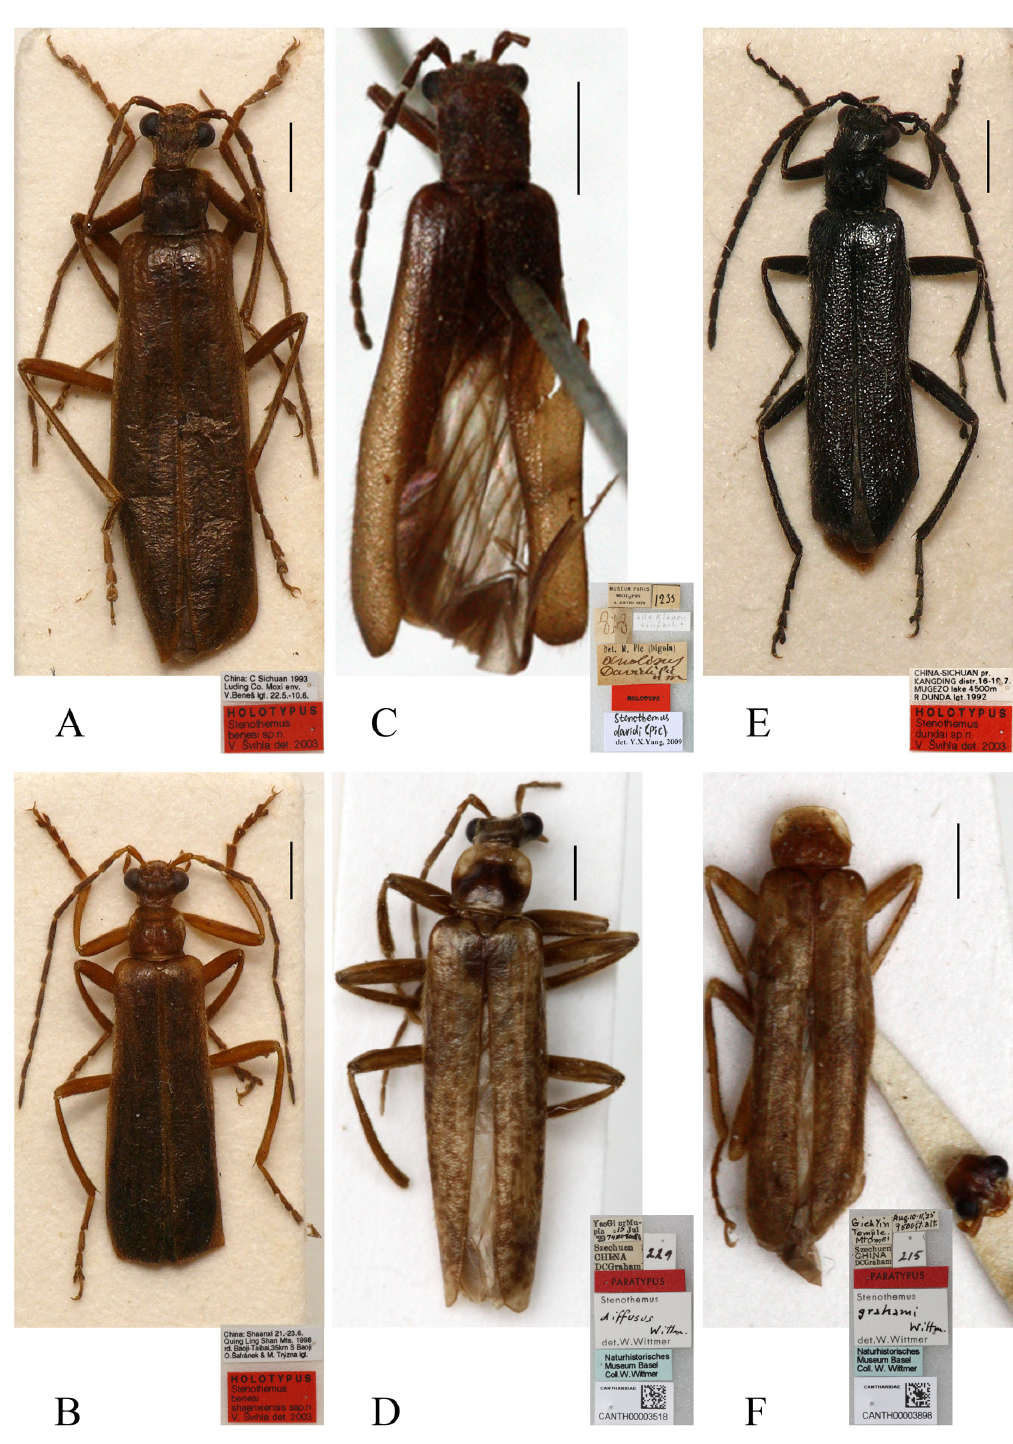
Fig. 1. Habitus, dorsal view. A . Stenothemus benesi Švihla, 2004, holotype, ♂ (NMPC). B . S . shaanxiensis Švihla, 2004 stat. nov., holotype, ♂ (NMPC). C . S. davidi (Pic, 1926) comb. nov., holotype, ♀ (MNHN). D . S . diffusus Wittmer, 1974, paratype, ♂ (NHMB CANTH00003518). E . S . dundai Švihla, 2004. holotype, ♂ (NMPC). F . S. grahami Wittmer, 1974, paratype, ♂ (NHMB CANTH00003898). Scale bars = 1.0